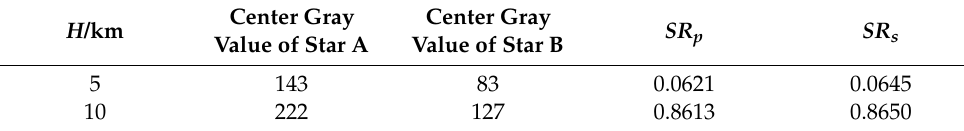
Table 1. The gray value at the center of the distorted star maps. H